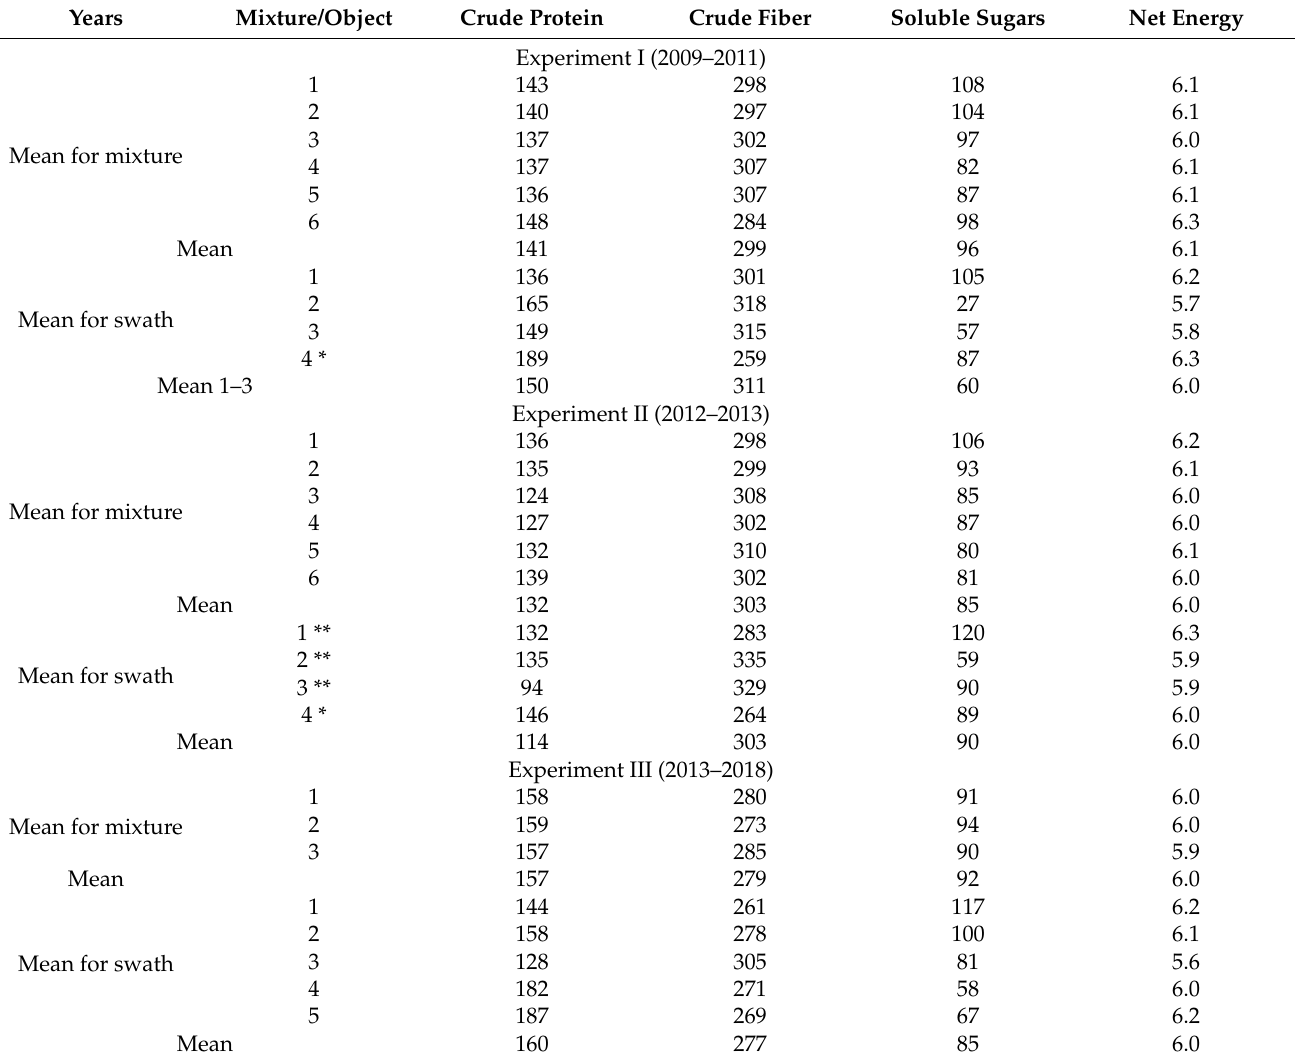
Table 9. The content of organic compounds (g · kg − 1 DM) and the concentration of net energy NEL (net energy lactation, MJ · kg − 1 DM) in the sward of the first